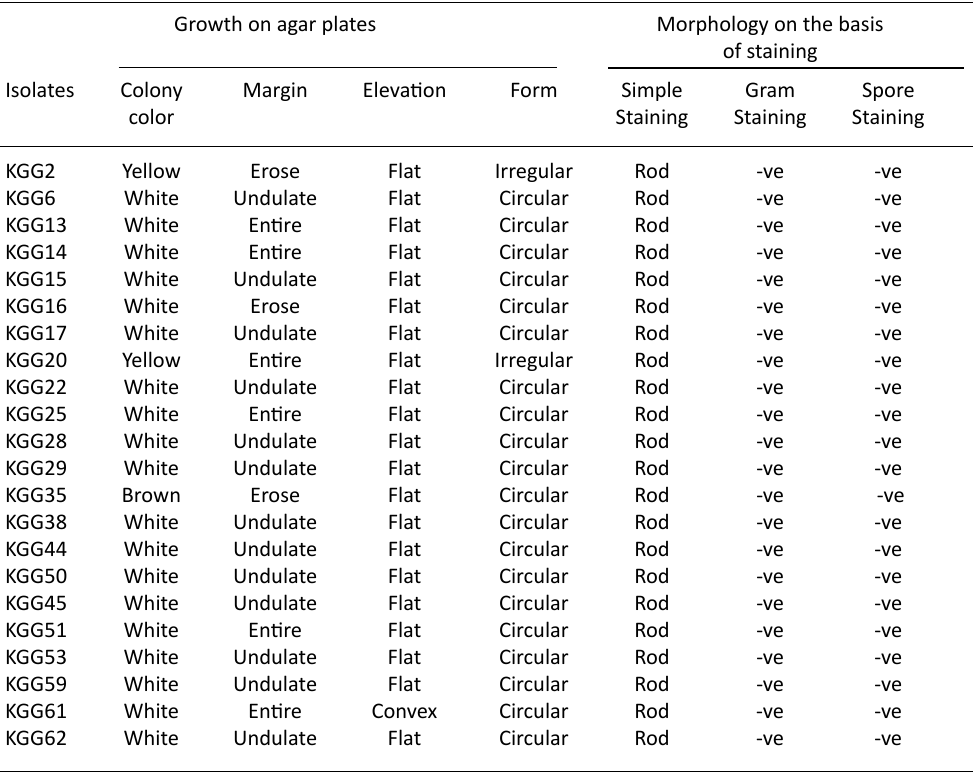
Table 2. Morphological characterization of the bacterial isolates Growth on agar plates Morphology on the basis of staining Isolates Colony Margin Elevation Form Simple Spore Staining Staining Staining Irregular Undulate Flat Circular KGG13 White Entire Flat Circular Entire Circular